Question: Describe this figure in one sentence.
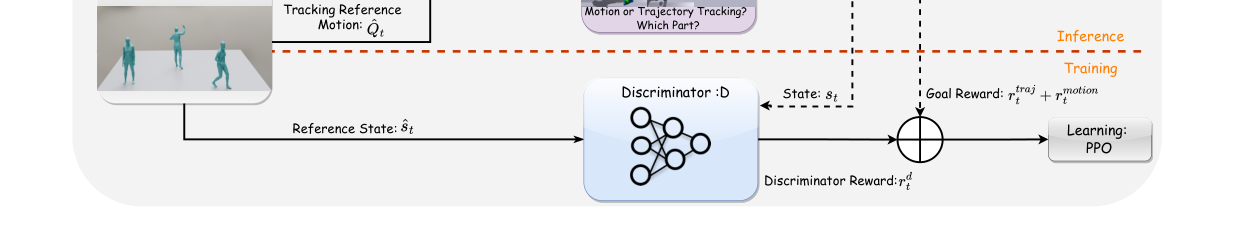
Answer: Framework of PACER+. Our framework follows the goal-conditioned reinforcement learning with Adversarial Motion Prior. To enable fine-grained control of specific body parts, we introduce an additional spatial-temporal mask to the motion-tracking task. This mask indicates the presence of a reference motion that the policy should track. By focusing on this tracking task, our framework enables the demonstration of diverse pedestrian behaviors at specific time steps and locations in a zero-shot manner.